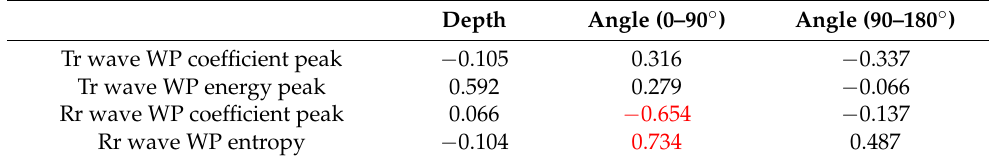
Table 3. Other correlation coefficients for